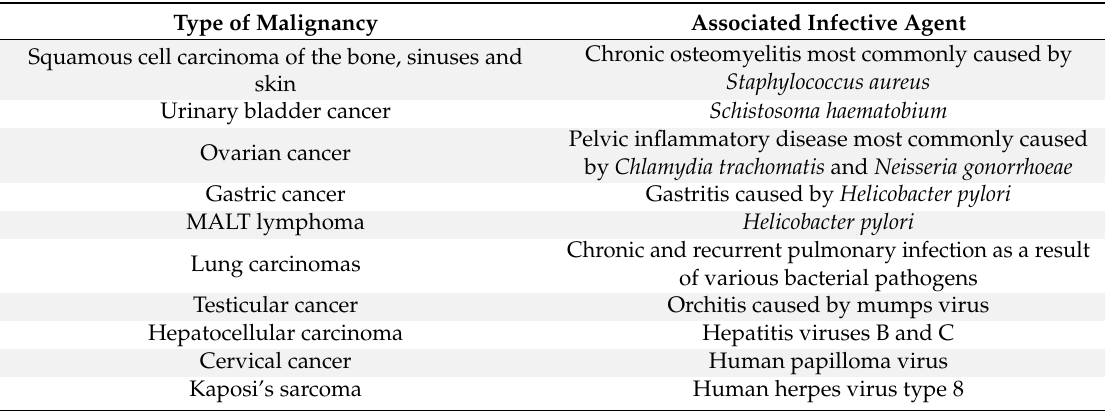
Table 2. Examples of inflammation-related malignancies of chronic non-infective origin. [2]